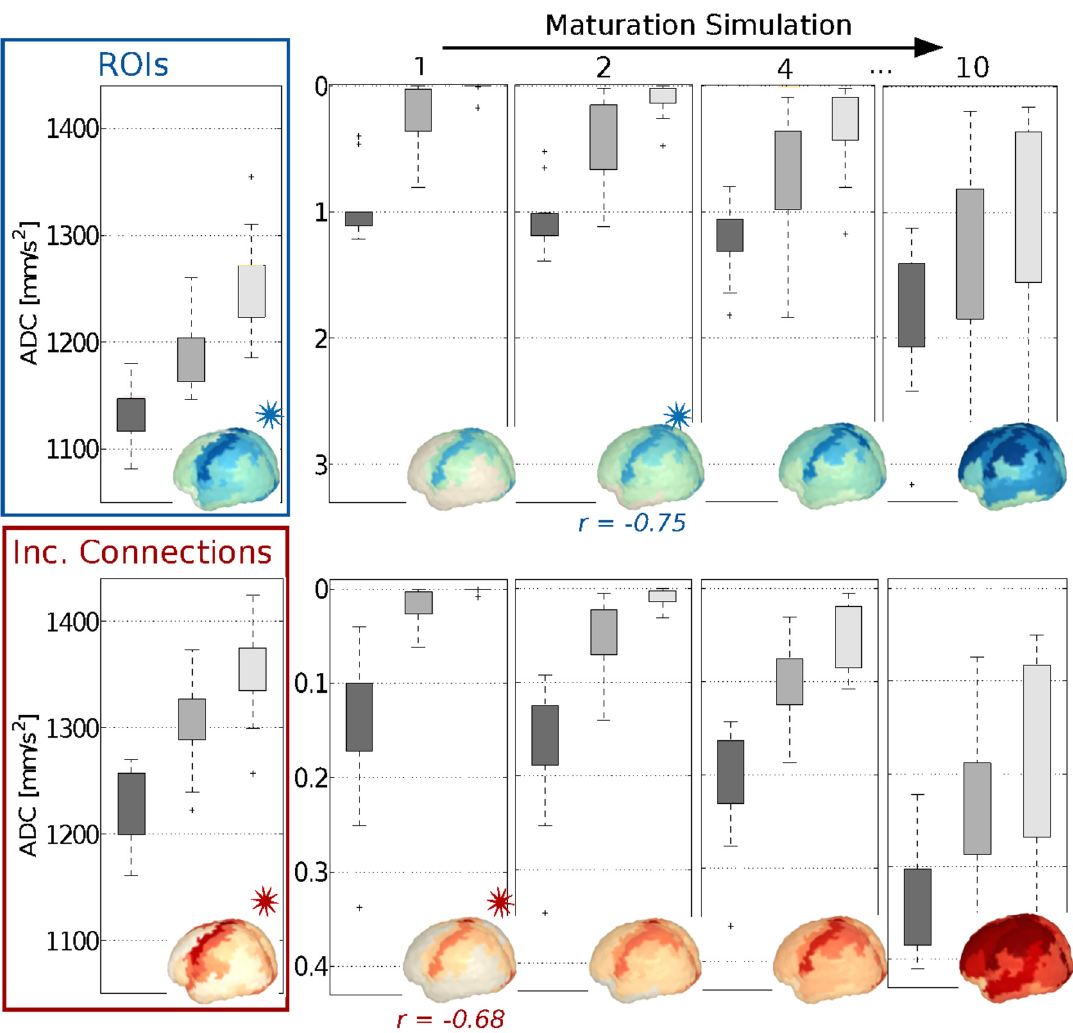
Fig 4. Histograms and brain surfaceplots for experimental ADC [10 − 6 mm/s 2 ] values (left) and modelled maturation scores (right, four key RWSs) in ROI groups. Top: ROIs; bottom: incidentconnections. Highest Pearson’scorrelationsare indicatedwith a star for the correspondingRWS (and